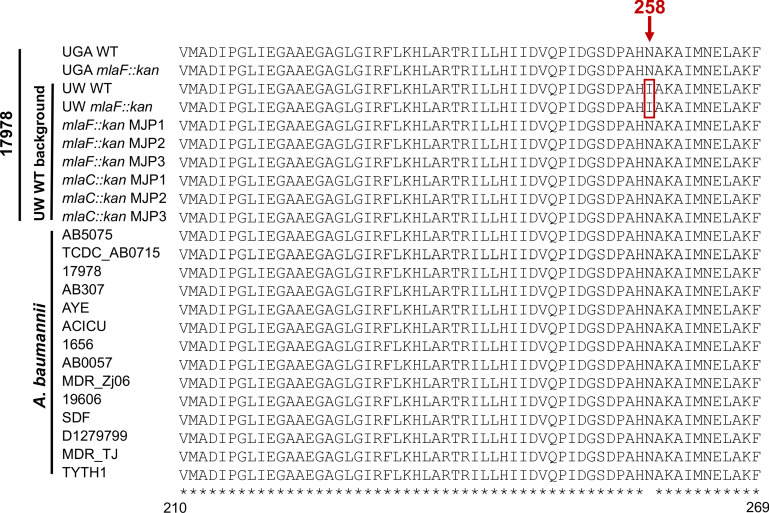
Multiple sequence alignment of obgE across A. baumannii.Portion displayed is from amino acid positions 210 to 269, with position 258 annotated by an arrow. Asterisks represent conservation across all samples. Top 10 rows are strains utilized during this study. Any strains derived from the UW WT are denoted. Bottom 14 rows are from published A. baumannii genomes. I258 is boxed in red.